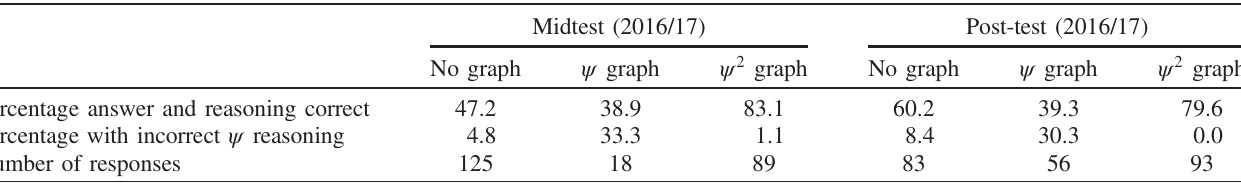
TABLE V. The percentage of responses with both correct answer and reasoning (top row) and the percentage of incorrect responses using ψ rather than ψ 2 in the inner product to calculate the energy correction (middle row), separated into students that made no graph, a graph of ψ , and a graph ψ 2 as for Table IV. The bottom row shows the number of responses used to determine each of the percentages. The mid- and post-test results were combined over both years.